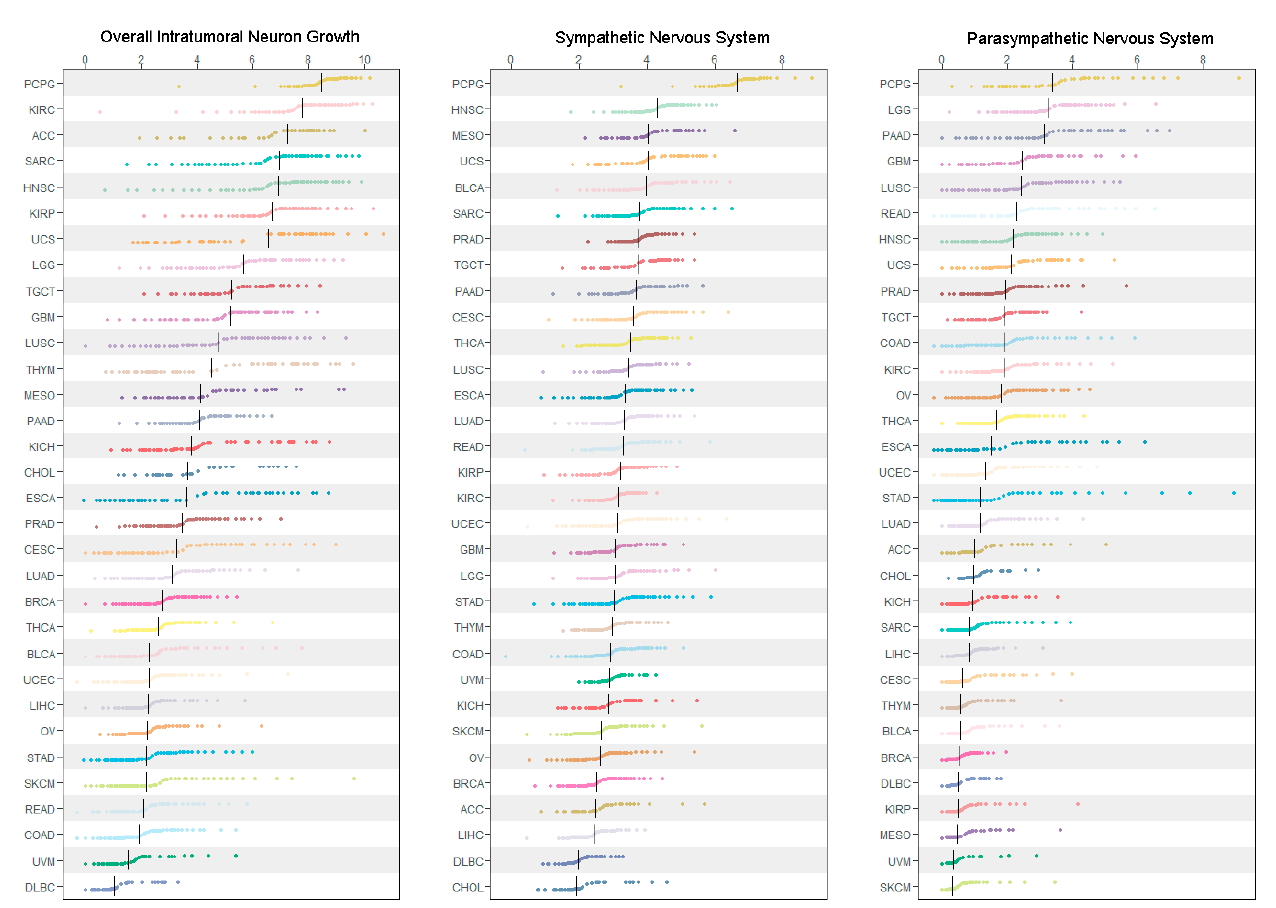
Figure 1. Pan-cancer characterization of autonomic nervous system gene expression